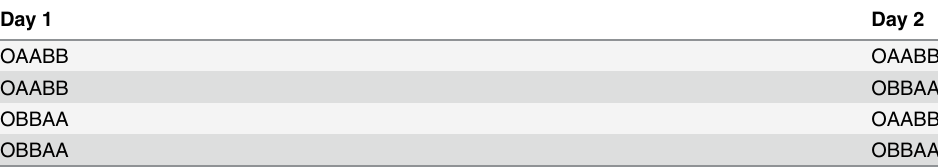
Table 1. Order of measurements: O is a test trial, A is rater 1 and B is rater